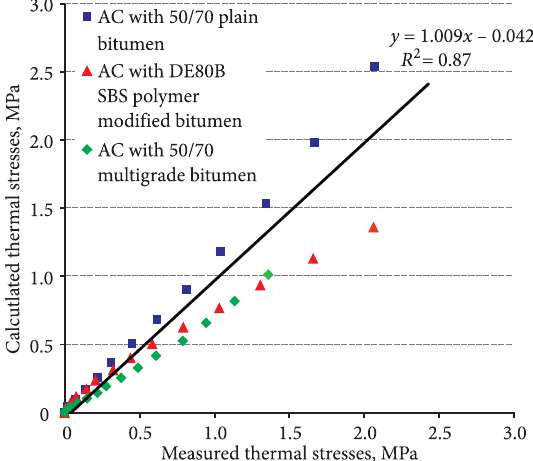
Fig. 9. Comparison of measured and calculated thermal stresses for three asphalt mixes with different